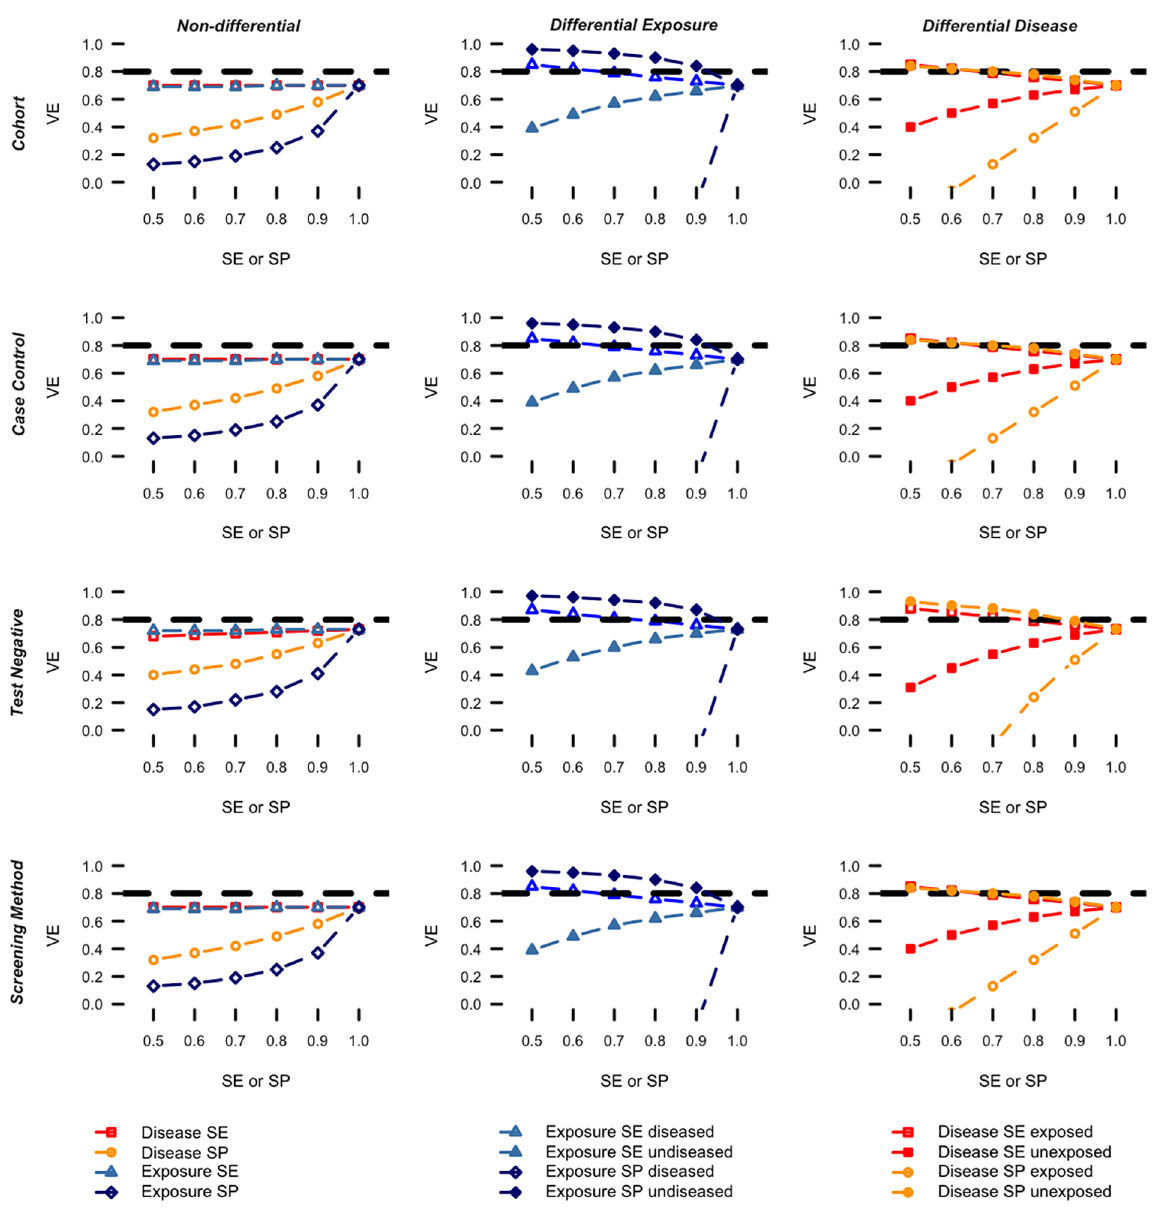
Fig 1. Influenza scenario: Vaccine effectiveness by design for varying levels of exposure- and disease misclassification while fixing the remaining parameters to 1. The dashed horizontal lines indicate the true VE used to simulate the data.